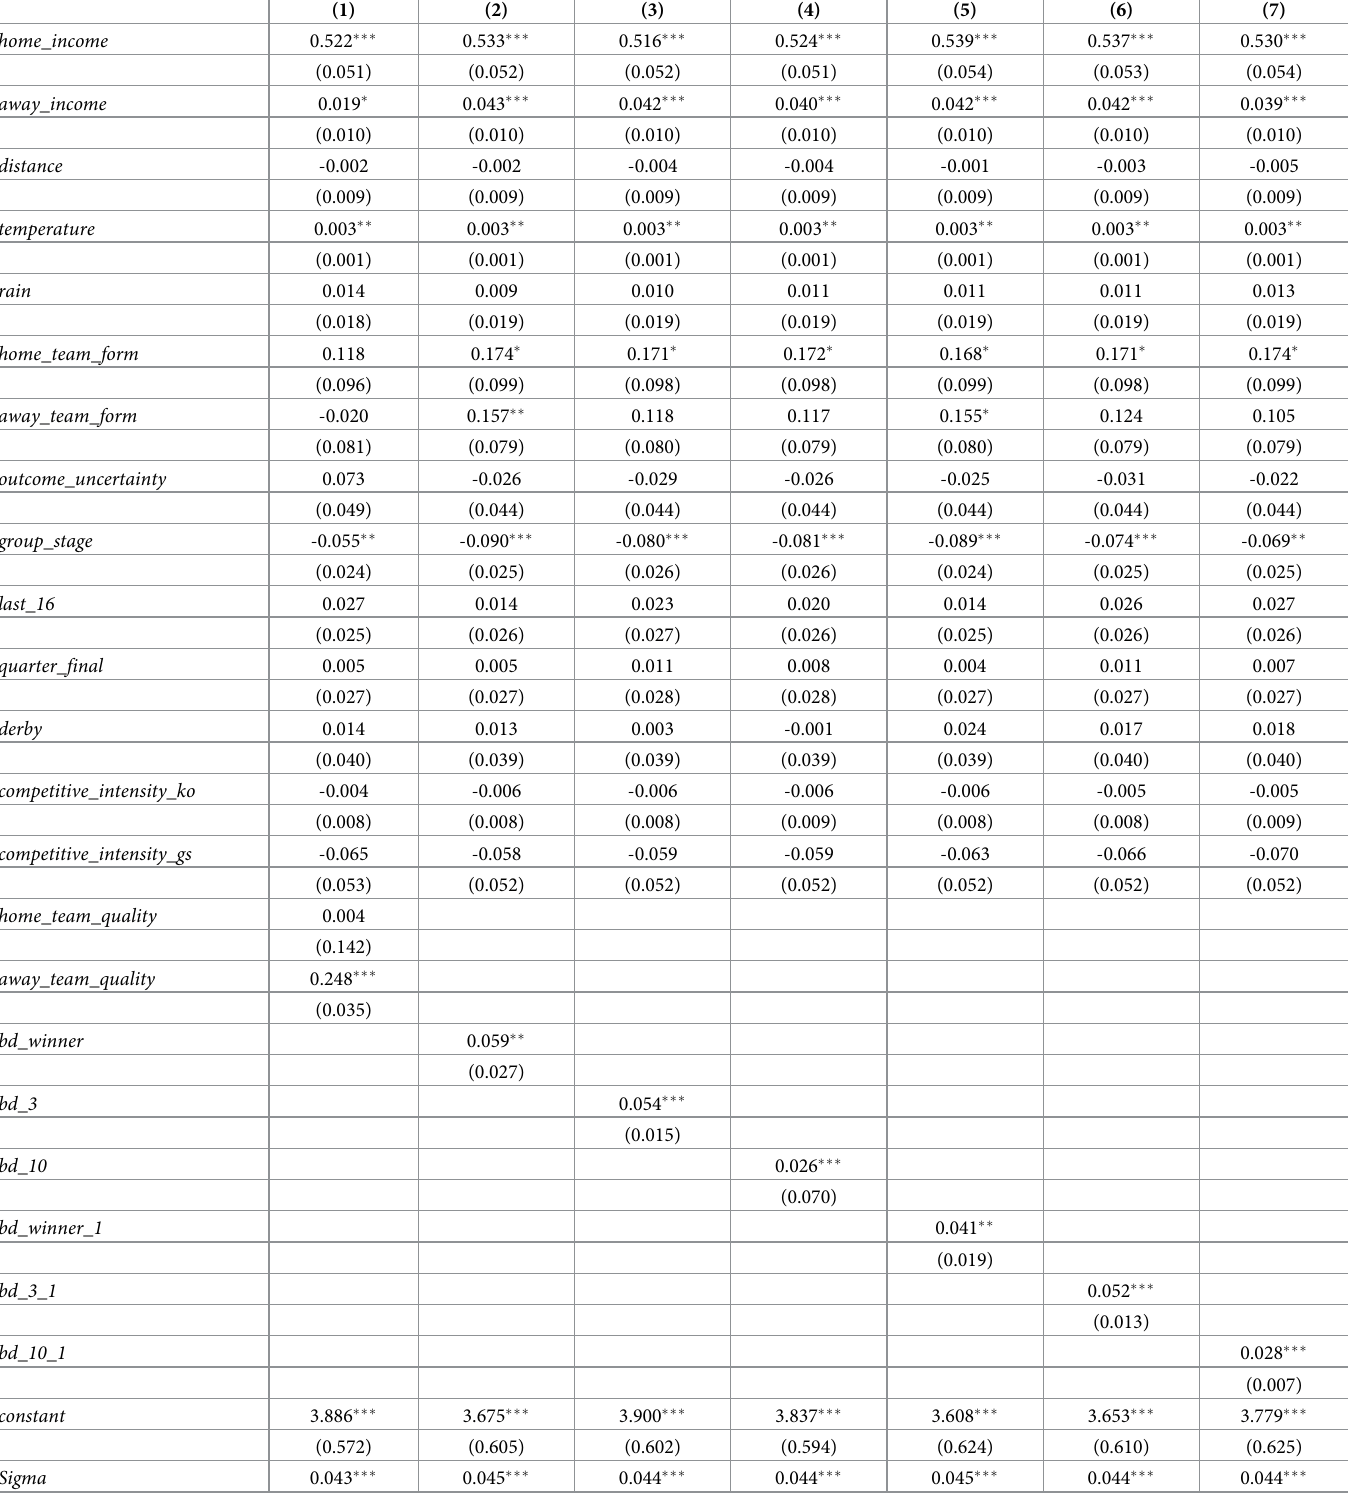
Table 2. UCL attendance, all